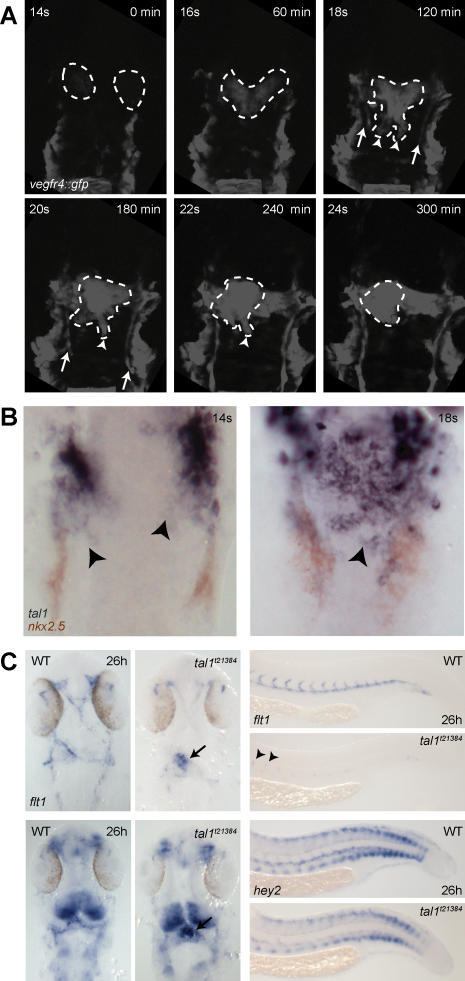
Migration of Endocardial Precursors and Heart Tube Formation in wt tal1t21384 Mutant Embryos(A) tal121384 mutant embryos transgenic for vegfr4:gfp were subjected to time-lapse confocal microscopy, revealing defects during early endocardial precursor migration. A movie demonstrating this process can be viewed in the Video S3. Six individual frames from this movie are shown in (A). Whereas the initial formation of bilateral endocardial precursors is not affected, posterior migration is disturbed, and endocardial precursors remain attached in a relative anterior position. Note that migration of the paired lateral dorsal aortae (arrows) proceeds normally.(B) tal1 expression in endocardial precursors. Two-color in situ hybridization revealing tal1 (blue) and nkx2.5 (red) expression in wt embryos at the 14- and 18-somite stage. tal1 expression is observed in endocardial but not myocardial precursors during their posterior migration (arrowheads).(C) Expression of the arterial markers flt1 and hey2 is retained in tal1t21384 mutant endocardium, but severely reduced in endothelium, as revealed by in situ hybridization. Dorsal view of flt1 and hey2 expression in the head, anterior to the top, and lateral view of flt1 and hey2 in the tail (28 hpf). In wt embryos, flt1 expression is observed in all head arteries, the aortic arches and the endocardium (arrow). In tal1t21384 mutant embryos, expression of flt1 is observed in a few remaining head arteries and the aortic arches. High levels are seen in the endocardium (arrow). In wt embryos, flt1 expression is observed in the dorsal aorta and the developing intersegmental vessels. In the tail of tal1t21384 mutant embryos, expression of flt1 is abolished, except for a few remaining cells that express flt1 at low levels (arrowheads). In wt embryos, hey2 expression is observed in the endocardium and the aortic arches and in some parts of the brain and spinal chord. In tal1t21384 mutant embryos, expression in the endocardium (arrow) is increased. In wt embryos, hey2 expression is observed in the dorsal aorta and the developing intersegmental vessels, spinal chord neurons, and in ventral and dorsal cells of the somites. In tal1t21384mutant embryos, expression in the dorsal aorta and intersegmental vessels is severely reduced, although some anterior intersegmental vessels and aortic cells retain low levels of hey2 expression (arrowheads).